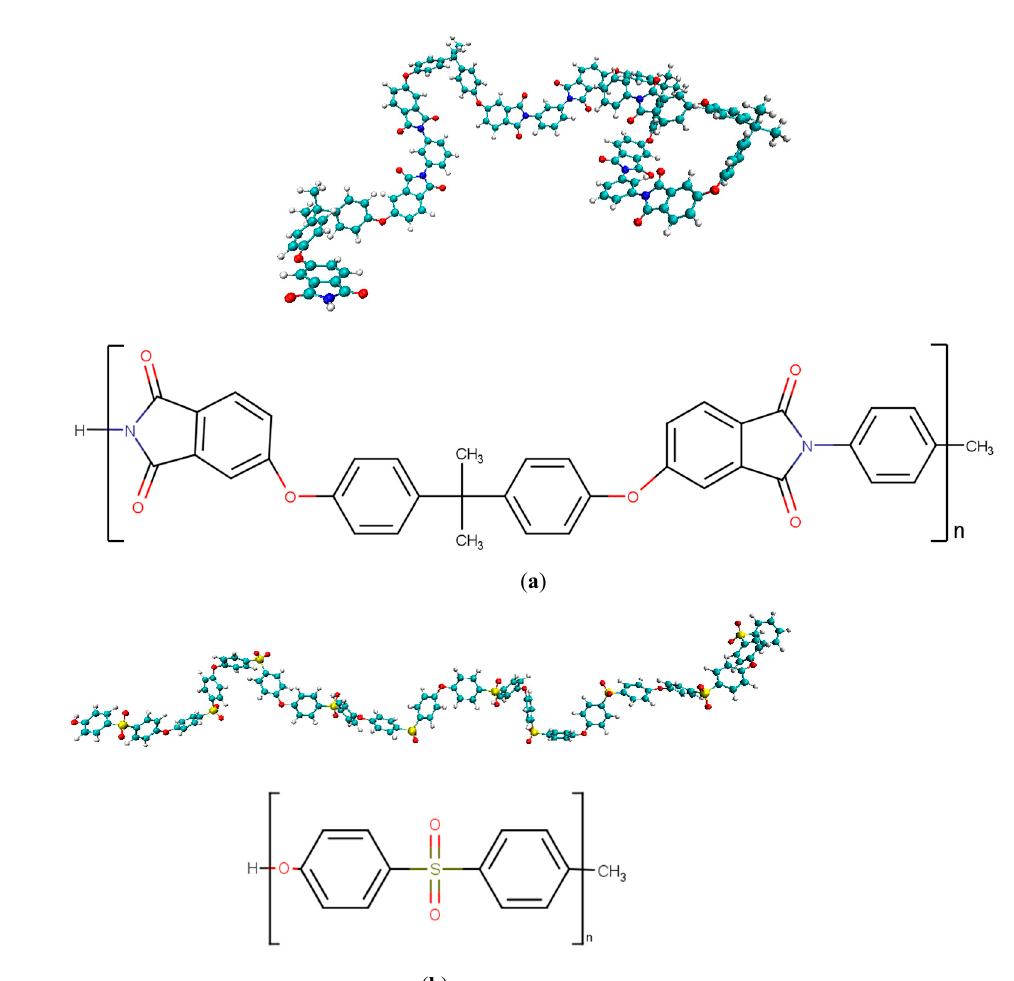
Figure 2. Snapshots and chemical structures of thermoplastic polymers: ( a ) PEI and ( b ) PES.